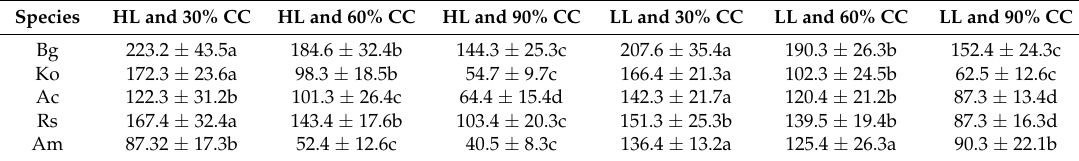
Figure 5. The stem diameter of seedlings of the five mangrove species (Bg = Bruguiera gymnorrhiza , Figure. 5. The stem diameter of seedlings of the five mangrove species ( Bg = Bruguiera Ac = Aegiceras corniculatum , Ko = Kandelia obovata , Rs = Rhizophora stylosa , Am = Avicennia marina ) gymnorrhiza , Ac = Aegiceras corniculatum , Ko = Kandelia obovata Rs = Rhizophora stylosa Am= ( A ) 30% canopy closure and high intertidal elevation, ( B ) 60% canopy closure and high intertidal Avicennia marina ) ( A ) 30% canopy closure and high intertidal elevation, ( B ) 60% canopy elevation ( C ) 90% canopy closure and high intertidal elevation, ( D ) 30% canopy closure and low closure and high intertidal elevation ( C ) 90% canopy closure and high intertidal elevation, ( D ) intertidal elevation, ( E ) 60% canopy closure and low intertidal elevation, ( F ) 90% canopy closure and 30% canopy closure and low intertidal elevation, ( E ) 60% canopy closure and low intertidal low intertidal elevation. elevation, ( F ) 90% canopy closure and low intertidal elevation. Table 3. The relative growth rate (RGR, mean ± SE) (mg g − 1 day − 1 ) of five mangrove species planted Table 3 . The relative growth rate (RGR, mean ± SE) (mg g -1 day -1 ) of five mangrove species in varying light level and intertidal planted in varying light level and intertidal elevation.